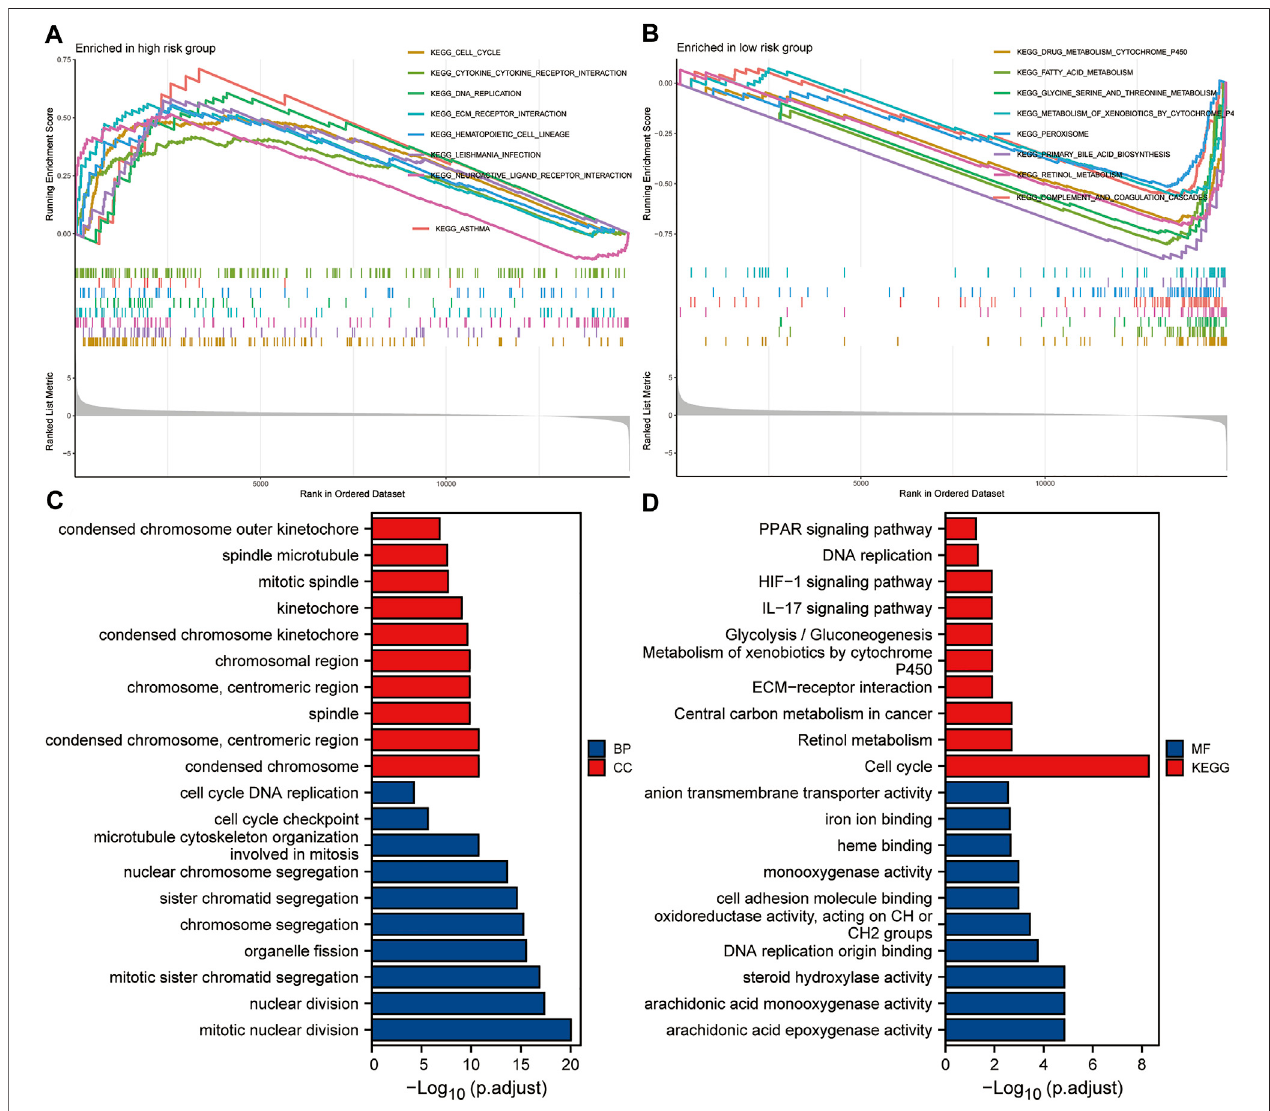
FIGURE 9 | Enrichment analysis based on the risk score. (A,B) GSEA analysis of high- and low-risk groups. (C,D) GO and KEGG analysis of DEGs between high- and low-risk groups.